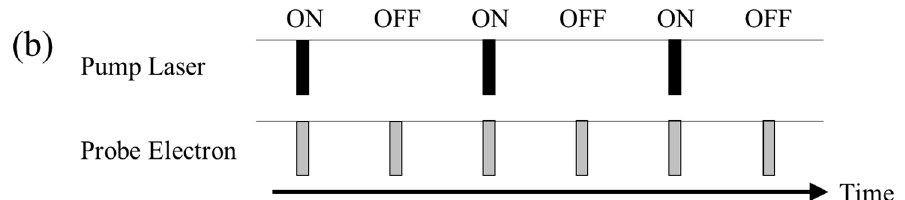
Figure 4. ( a ) Schematic diagram of a data gathering system, representing delay lines (DLs), a constant fraction discriminator (CFD), a multivibrator (MV), and a time-to-digital converter (TDC). ( b ) Timing sequence diagram of concurrent measurement of laser-on and laser-off data sets. See text for details.